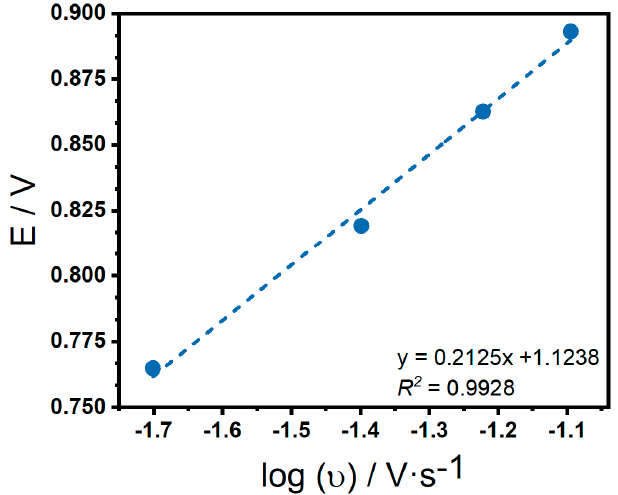
Figure 12. Linear regression to anodic potential against logarithmic sweep rate of glucose 10 mM on CNT-SPE/A/AuNPs in Sorensen buffer pH 7.